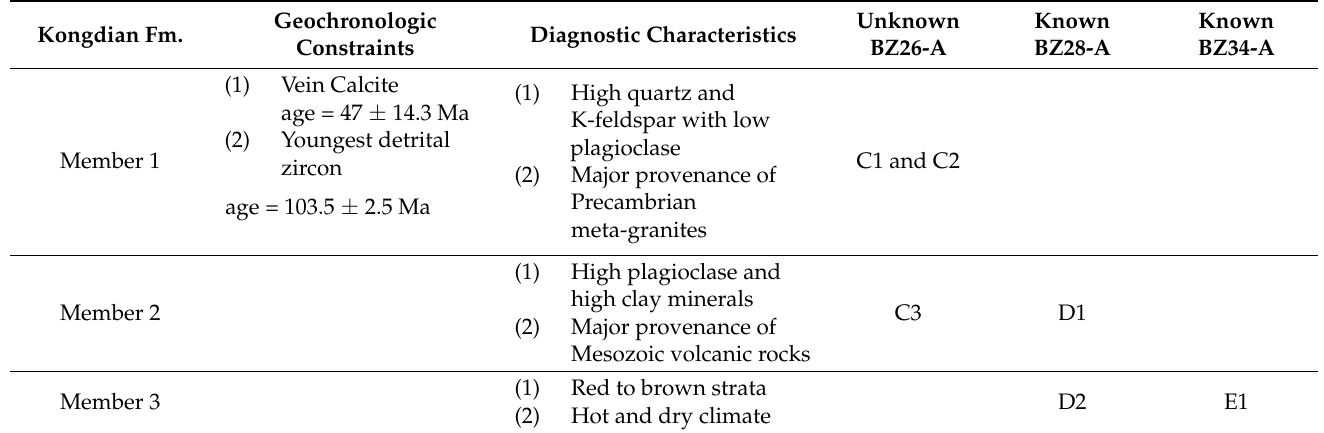
Table 1. Schematic correlation chart of the Kongdian Formation in Huanghekou Sag. Kongdian